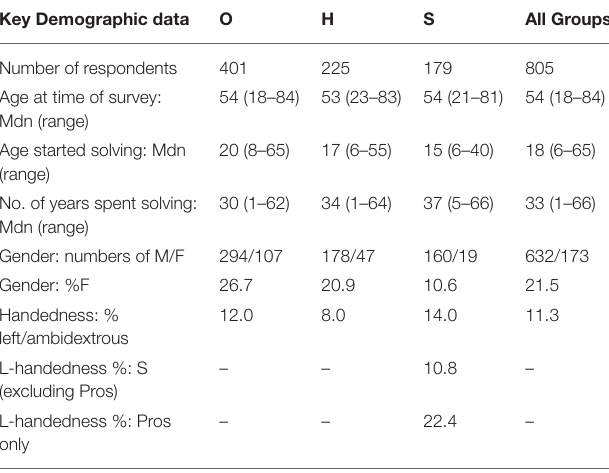
TABLE 1 | Key demographic data, by expertise